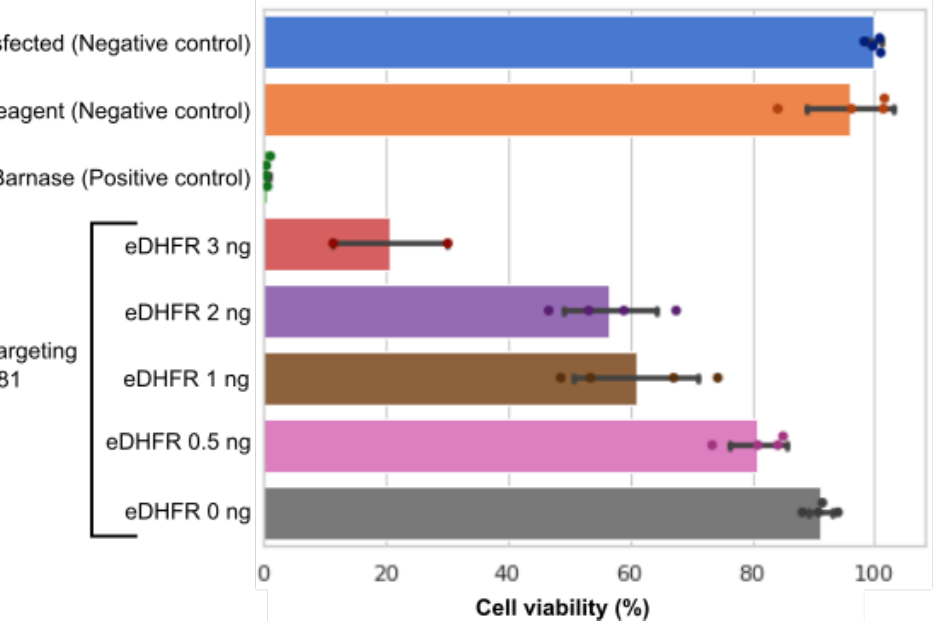
Figure 4. Relationship between the amount of transfected eDHFR mRNA and reconstitution of Bn protein, as measured by cell viability. Cell viability was measured 2 days after cotransfecting Bn-81 mRNA (45 ng/well of both N- and C-terminal Bn-81), Barstar mRNA (1 ng/well), and eDHFR mRNA (3, 2, 1, 0.5, or 0 ng/well). The transfection reagent without mRNA was used as a negative control, and full-length Bn mRNA (90 ng/well) was used as a positive control.